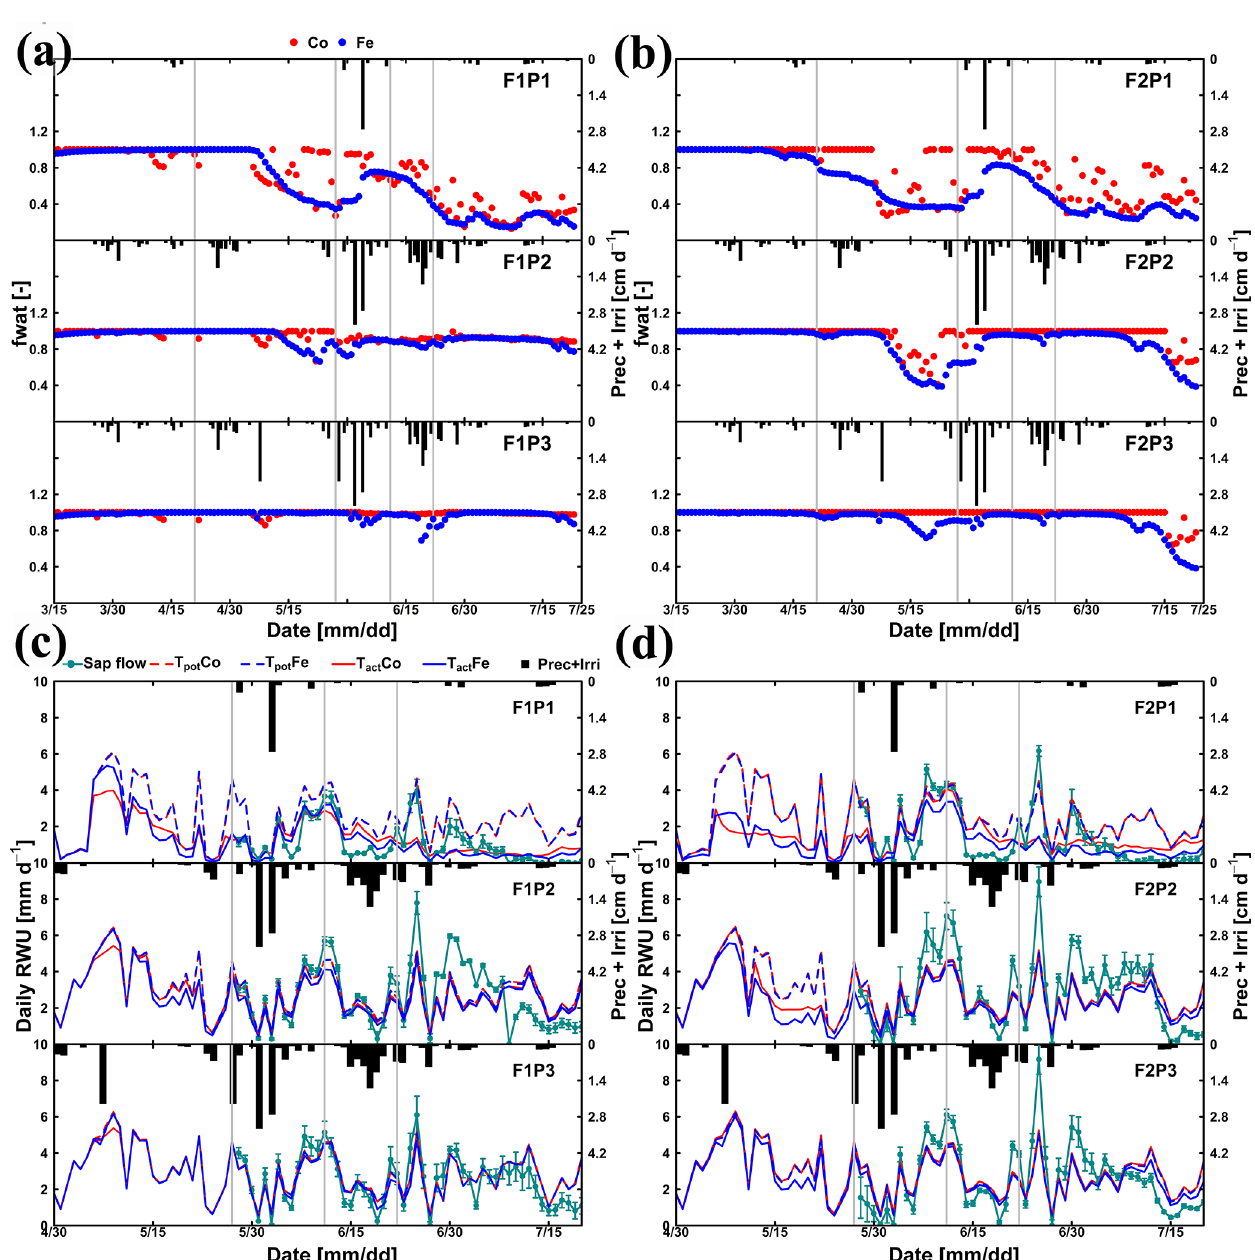
Figure 5. Daily transpiration reduction factor ( f wat ) (a, b) from 15 March to harvest on 23 July 2016 and comparison between observed (cyan) and simulated root water uptake (RWU) and potential transpiration simulated (c, d) by the Couvreur (Co; closed red) and Feddes (Fe; closed blue) models from 30 April to 20 July 2016 in the sheltered (P1), rainfed (P2), and irrigated (P3) plots of the stony soil (F1) and the silty soil (F2). Time series of precipitation (Prec) and irrigation (Irri) are given in the panels. Note that crop germination was on 26 October 2015. Vertical cyan bars represent the standard deviation of the flux measurements in the different stems. Vertical grey lines show days with the measured and simulated diurnal courses of root water uptake (RWU), leaf water pressure head ( ψ leaf ), stomatal conductance ( g s ), and gross assimilation rate ( P g ) as used in Fig.